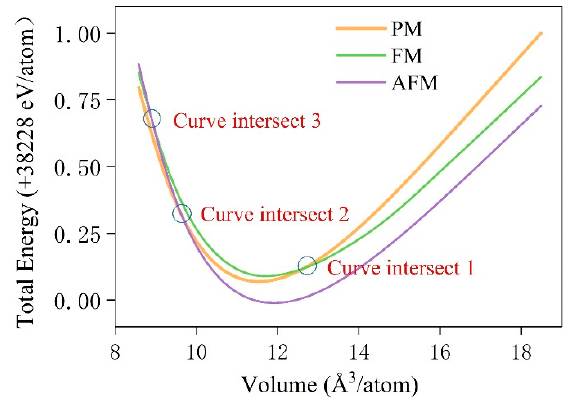
Figure 1. The energy versus volume curves of paramagnetic (PM), ferromagnetic (FM) and antiferromagnetic (AFM) phases for L1 2 - (Ni,Cu) 3